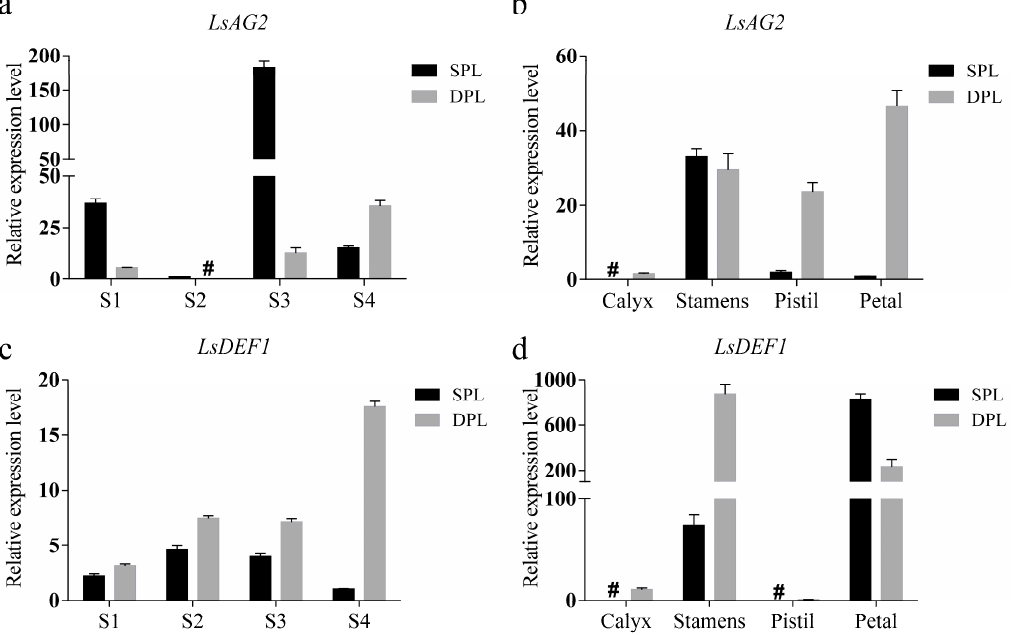
Figure 2. The expression patterns of LsAG2 and LsDEF1 . ( a ) Expression level of LsAG2 during different developmental stages. ( b ) Expression level of LsAG2 in different flower tissues. ( c ) Expression level of LsDEF1 during different developmental stages. ( d ) Expression level of LsDEF1 in different flower tissues. S1 to S4, four different development stages of flower budding. SPL, single-petaled L. speciosa ; DPL, double-petaled L. speciosa . In the same type of tissue or developmental stage, the sam- ple with the lowest expression was selected as the control, and the gene expression levels were cal- culated using the 2 −∆∆ Ct method. The symbol ‘#’ indicates that the gene cannot be detected.